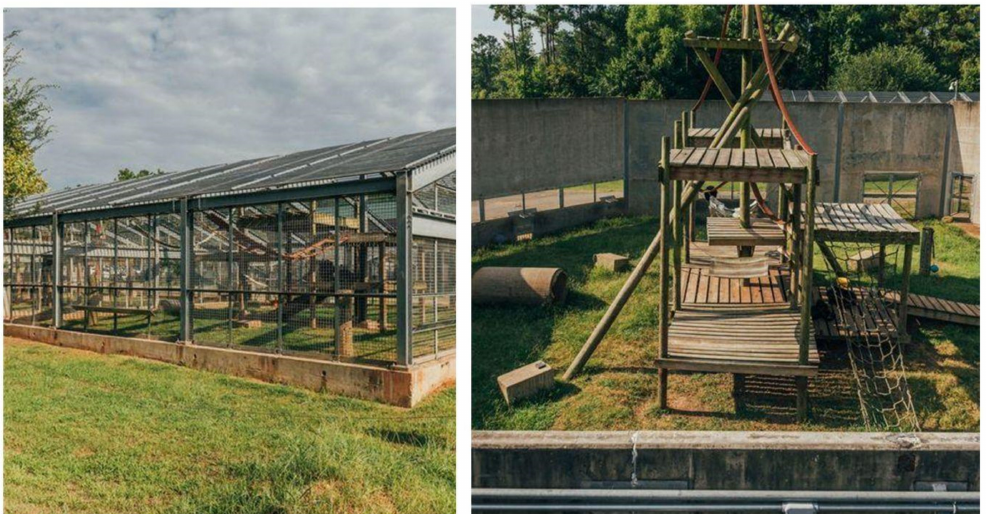
Figure 2. Left : A photo of a closed topped enclosure with brachiating bars at Chimp Haven used for social integrations. Right : A photo of a large open topped corral at Chimp Haven utilized for social